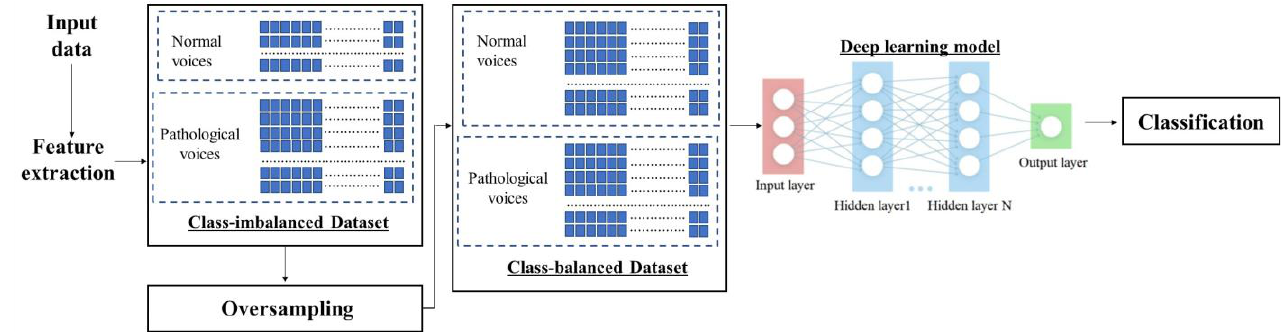
Figure 1. Structure of the proposed algorithm.